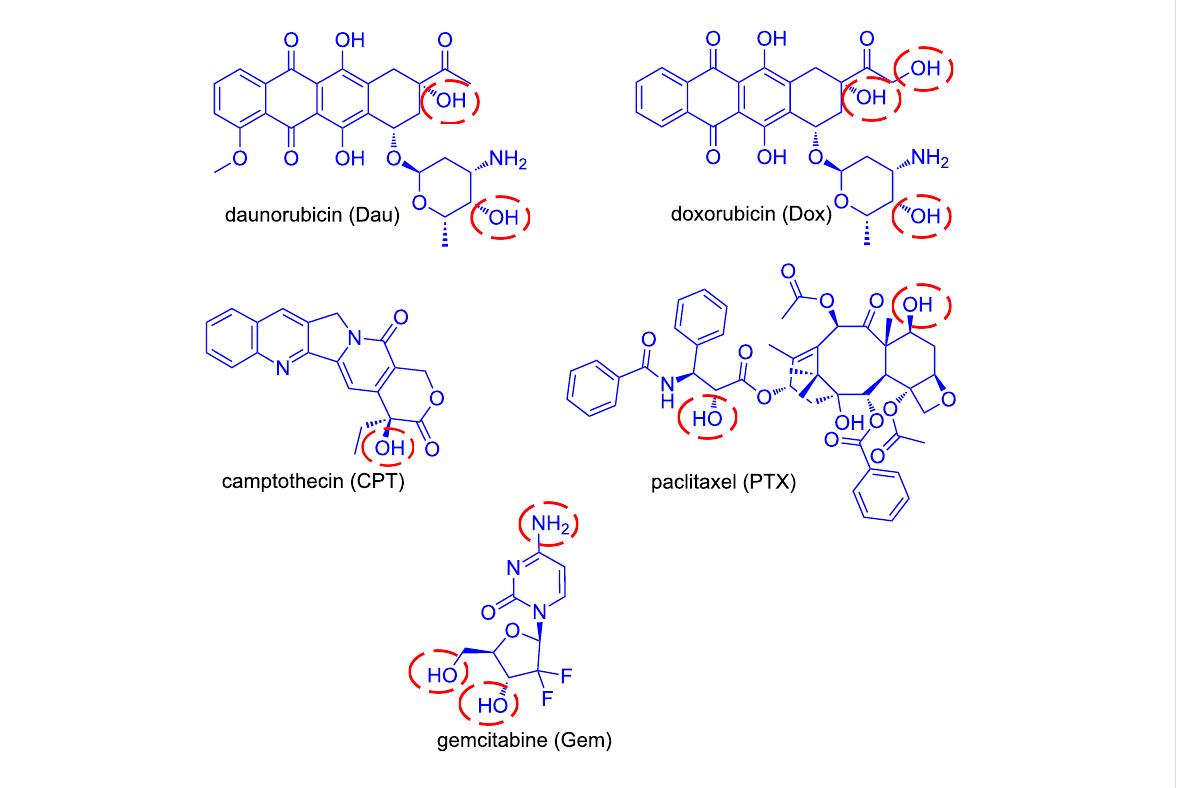
Figure 4: Representative examples of anticancer drugs utilized for the construction of PDCs. The most usual conjugation sites are marked with red cycles.